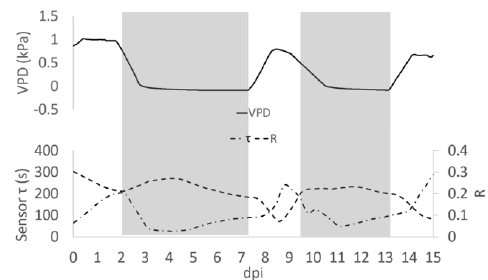
Figure 5. Average of R measured during the day post insertion (dpi) on all plants at Vg = 1 (dashed line), τ signal (dashed and pointed line) and the calculated VPD trend (solid line). Grey block indicates when the Low VPD conditions were applied.